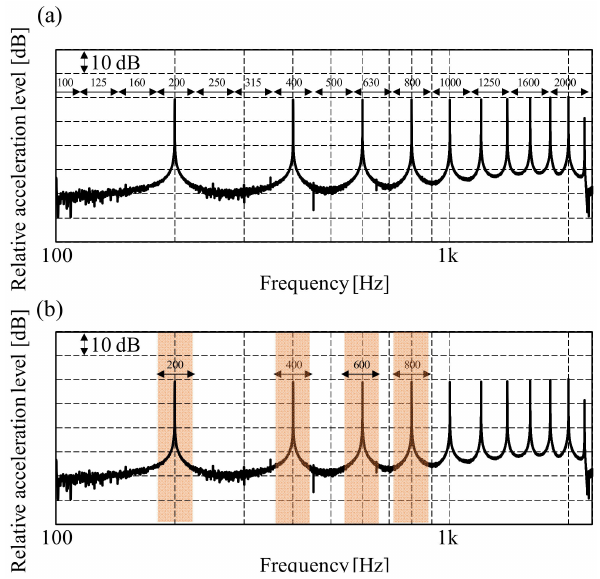
Figure 5. Two methods for selecting frequency bands: ( a ) using a constant percentage bandwidth and ( b ) using peak